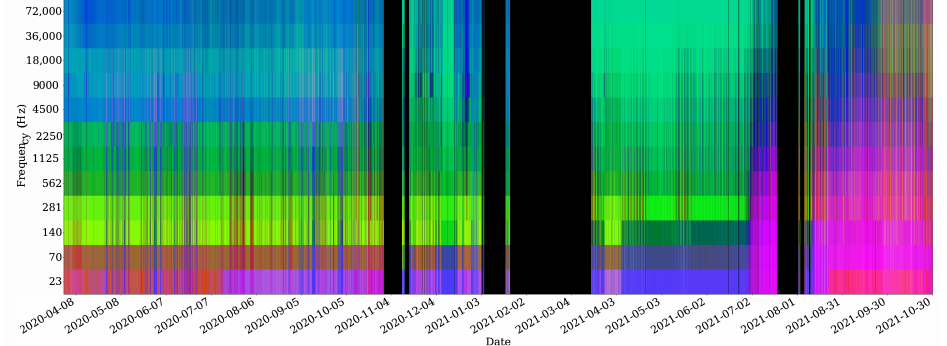
Figure 9. Acoustic indices implemented in MASE (ACI, H t , and energy spectrum) integrated in a single graphic as false colour spectrogram.